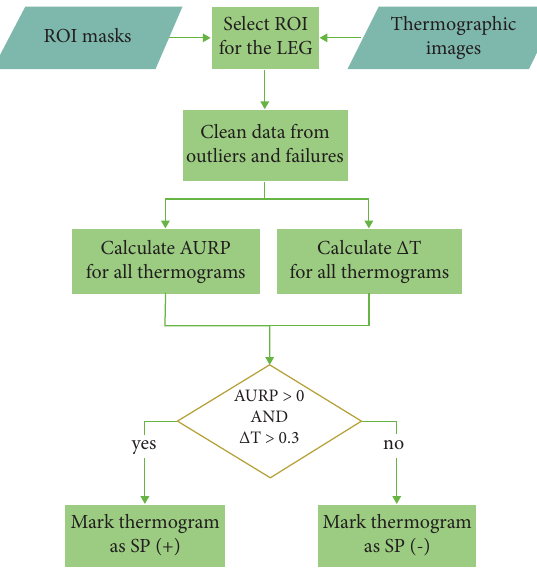
Figure 2: Te procedure applied for calculating the fnal results of the SP test ®